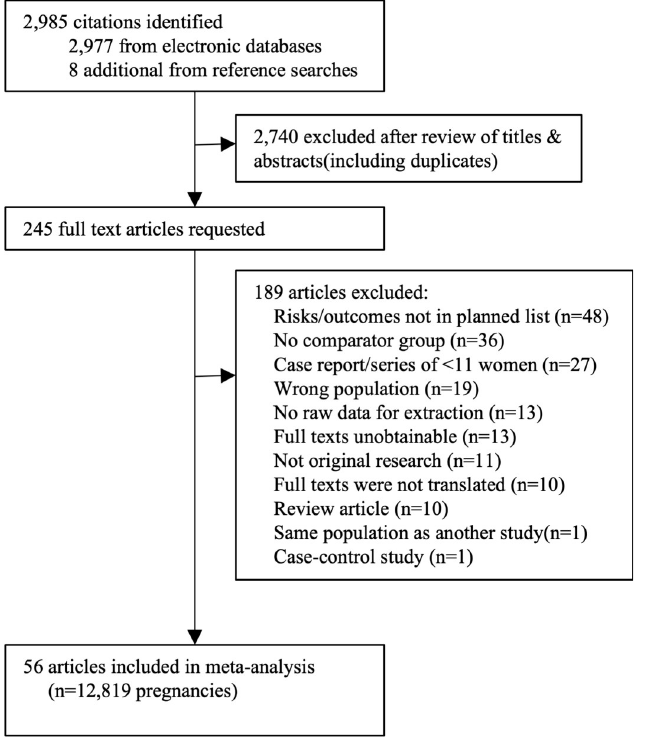
Fig 1. PRISMA flow chart of included studies in the systematic